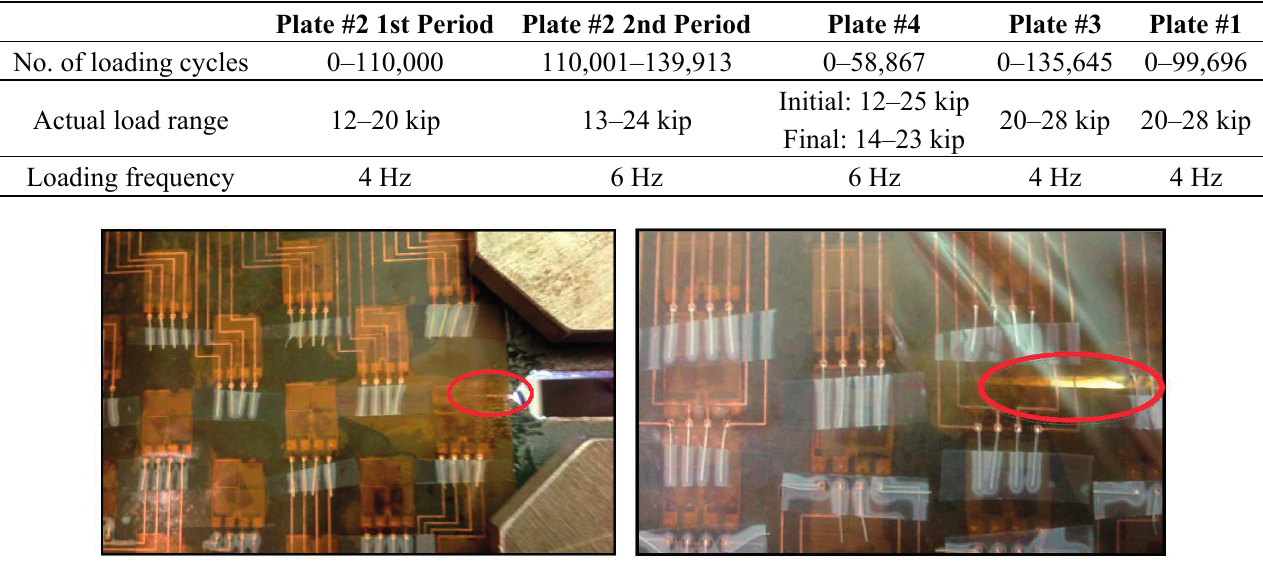
Figure 13. ( Left ): initial crack occurring on Plate #2 (sensing sheet Design 1); ( Right ): initial crack occurring on Plate #1 (sensing sheet Design 2).